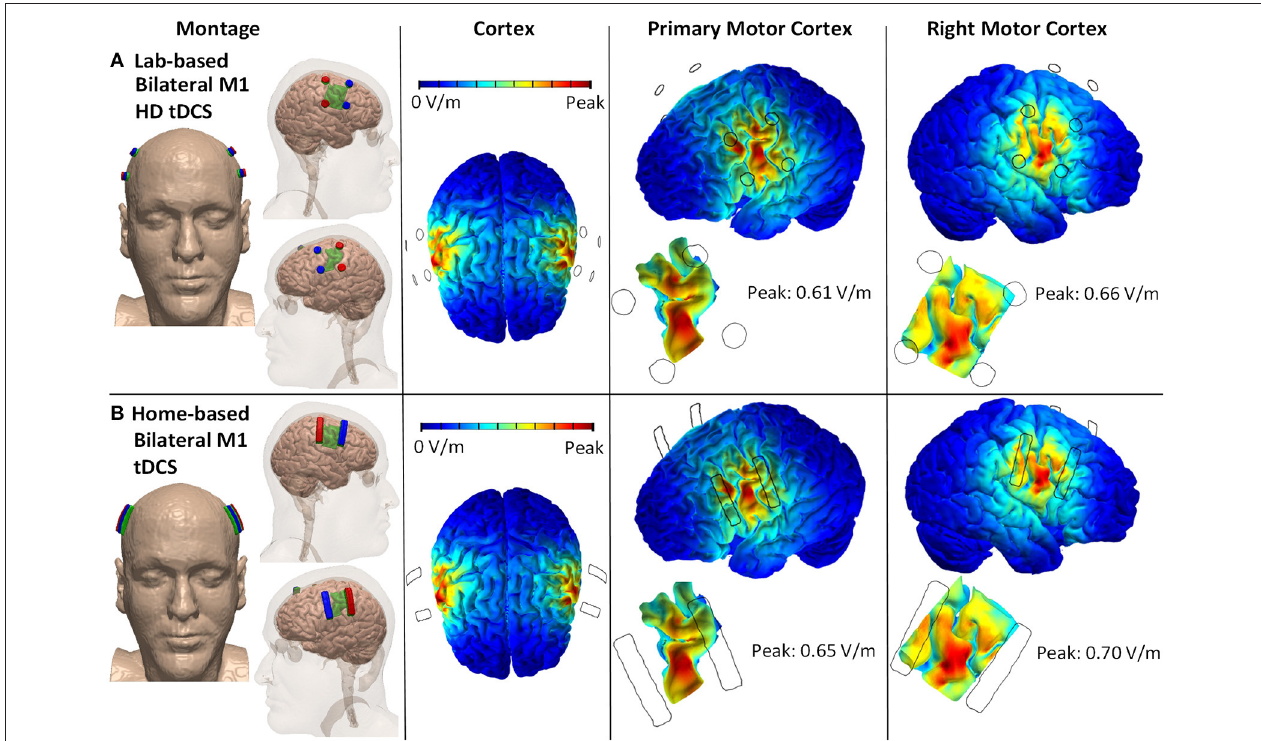
FIGURE 1 | Lab- and home-based bilateral M1 HD-tDCS montages and computational modeling on 3D rendered head built from the MRI derived segmentation masks. (A) Lab-based with anode (red) placed over C3/C5 and cathode (blue) over FC3/FC5. (B) Home-based (strip) covering same